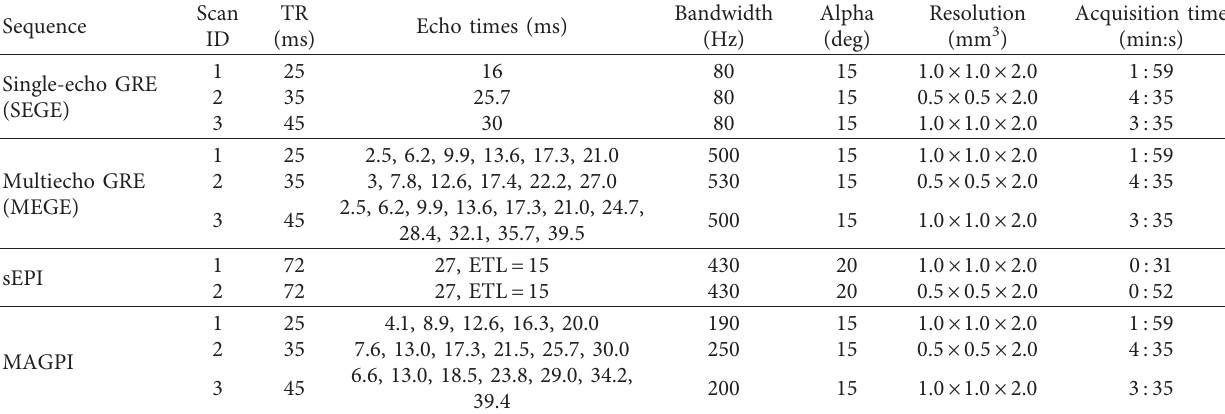
Figure 1: (a) 3D diagram of the rotating-tube phantom design with five smaller cylindrical samples along with temperature probe. (b) Magnitude images of the sagittal (one tube), axial, and coronal (multiple tube) views. (c) A photograph of the 5 tubes. (d) 3D rendering from MRI magnitude images. Table 1: All data acquisition